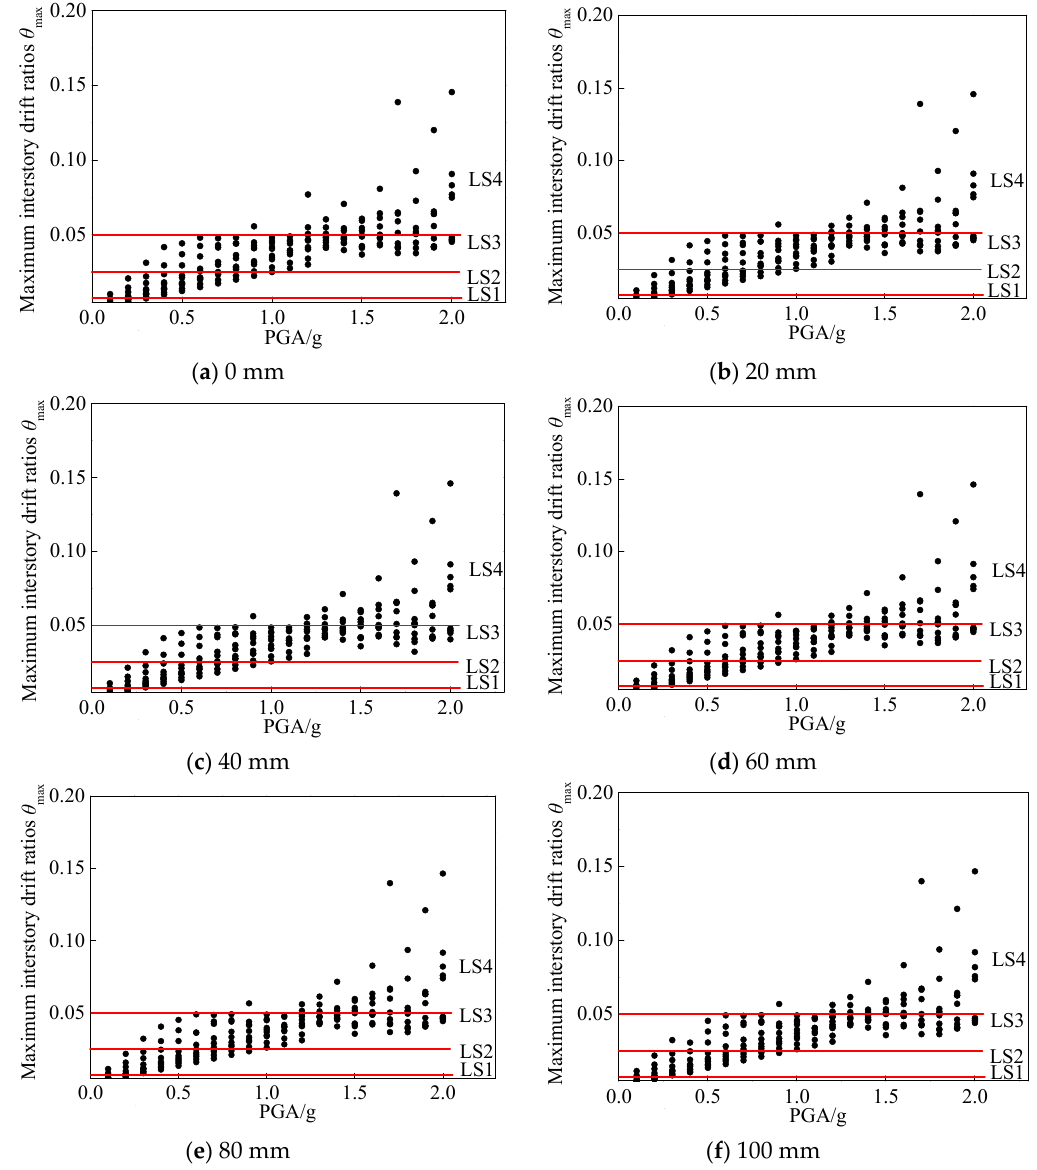
Figure 5. Relationship between the structural demand and PGA of Zone III. Table 2. The interstorey drift ratios limits for di ff erent performance